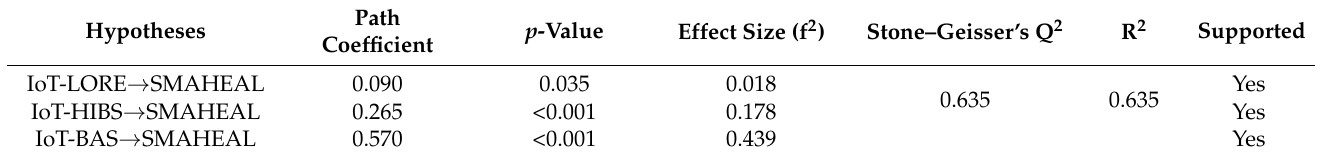
Table 5. Testing of the study hypotheses.